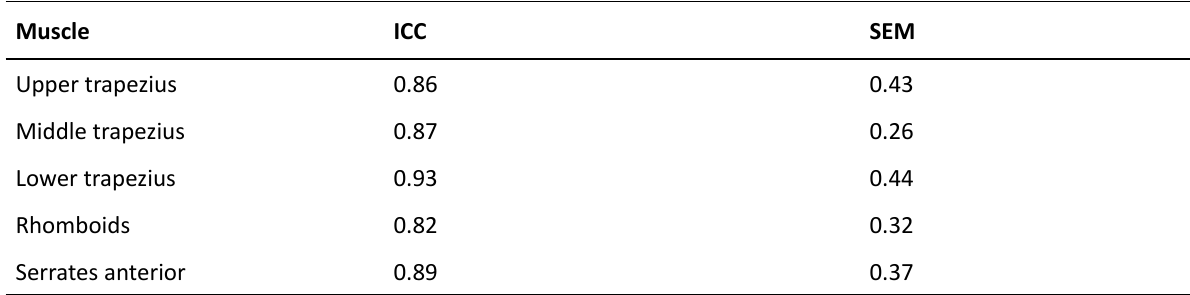
Table 2. Subjects Classified by Activity Level